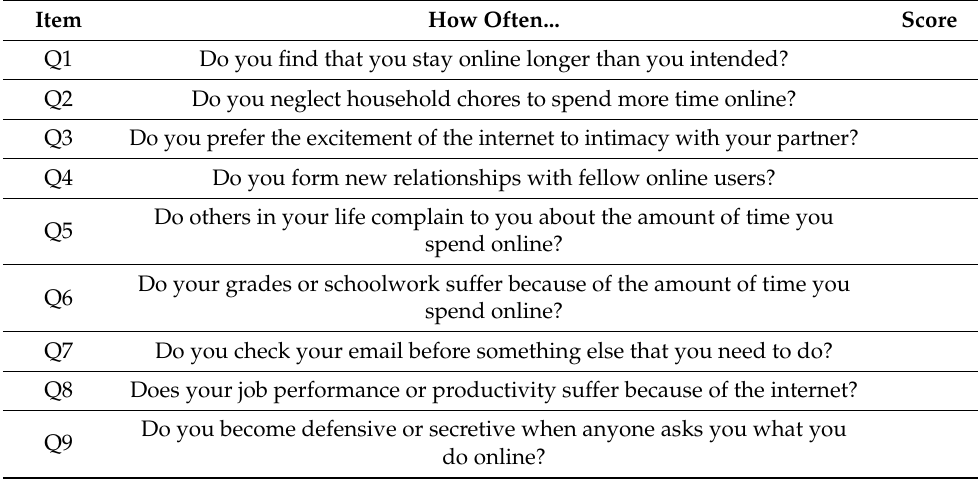
Table A1. Young’s internet addiction test